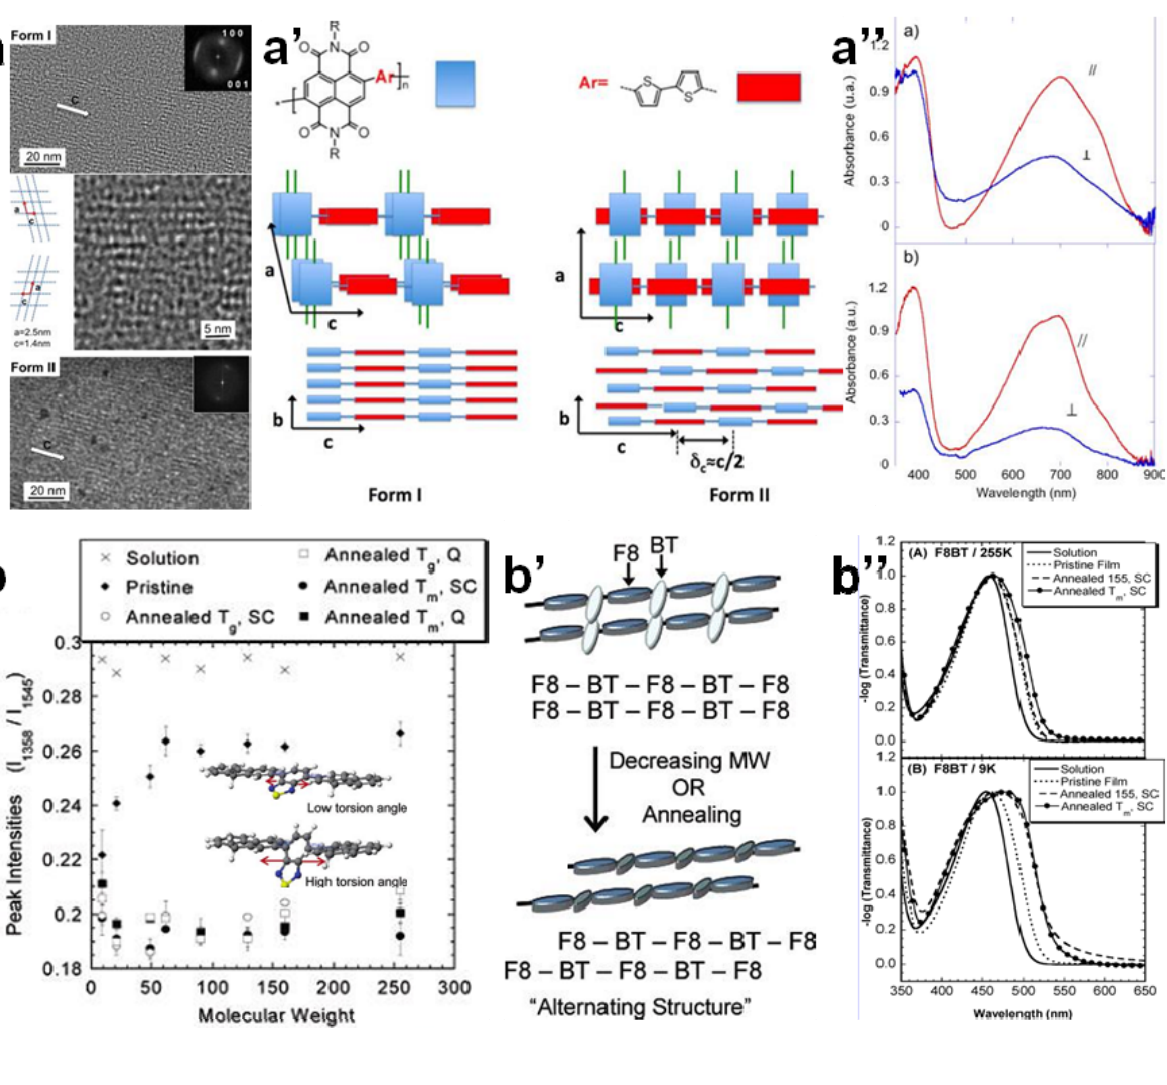
Figure 8. The HR-TEM photos and corresponding fast Fourier transforms of Form I and Form II stacking structures in ( a ); the schematic illustration of Form I and Form II in ( a’ ) and the polarized UV-Vis spectra of Form I (upper) and Form II (down) in ( a’’ ) for P(NDI2OD-2T) (Adapted with permission from [113]. Copyright 2012 American Chemical Society); The variation of Raman intensity ratio representing inter-chain torsion with molecular weight (larger ratio for larger torsion) in ( b ); the schematic illustration of conformational change due to different inter-ring torsion in ( b’ ) and the UV-Vis spectra in ( b’’ ) for F8BT, (Adapted with permission from [114]. Copyright 2005 American Chemical